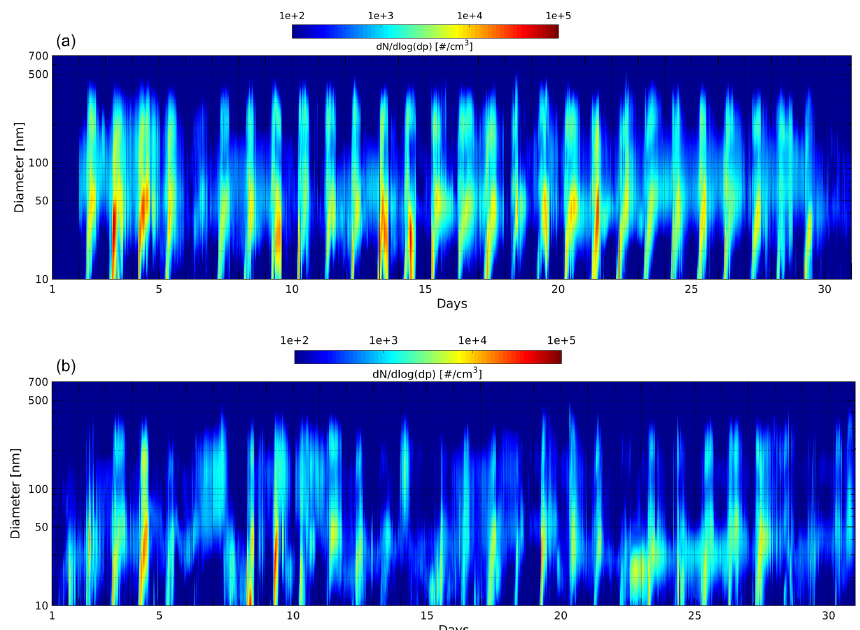
Figure A4. DMPS spectra for (a) April and (b) June months. We can clearly observe an event number difference between the two months according to the different NPF occurrence averages which are 93.1% for April and 46.7% for